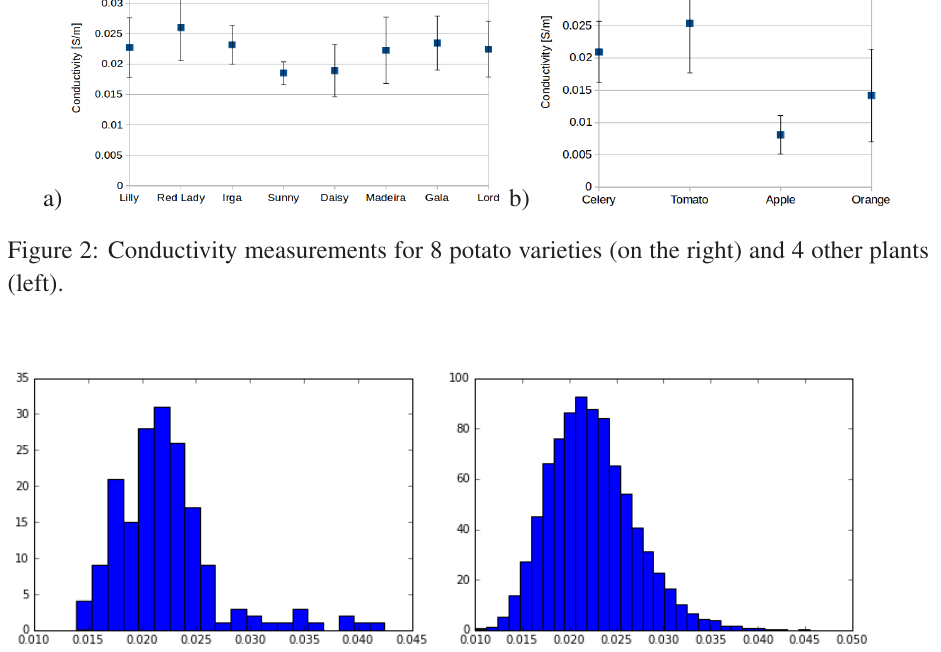
Figure 3: Histogram of 175 conductivity measurements of the raw potato tissue (right) and its lognormal PDF approximation